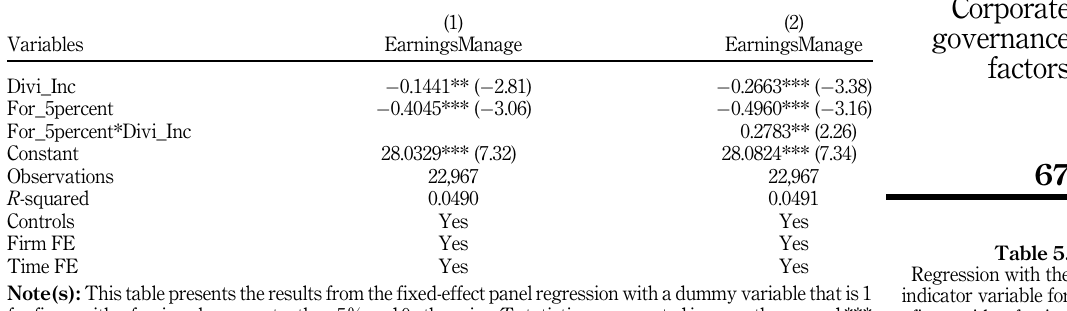
Table 5. Regression with the indicator variable for firms with a foreign